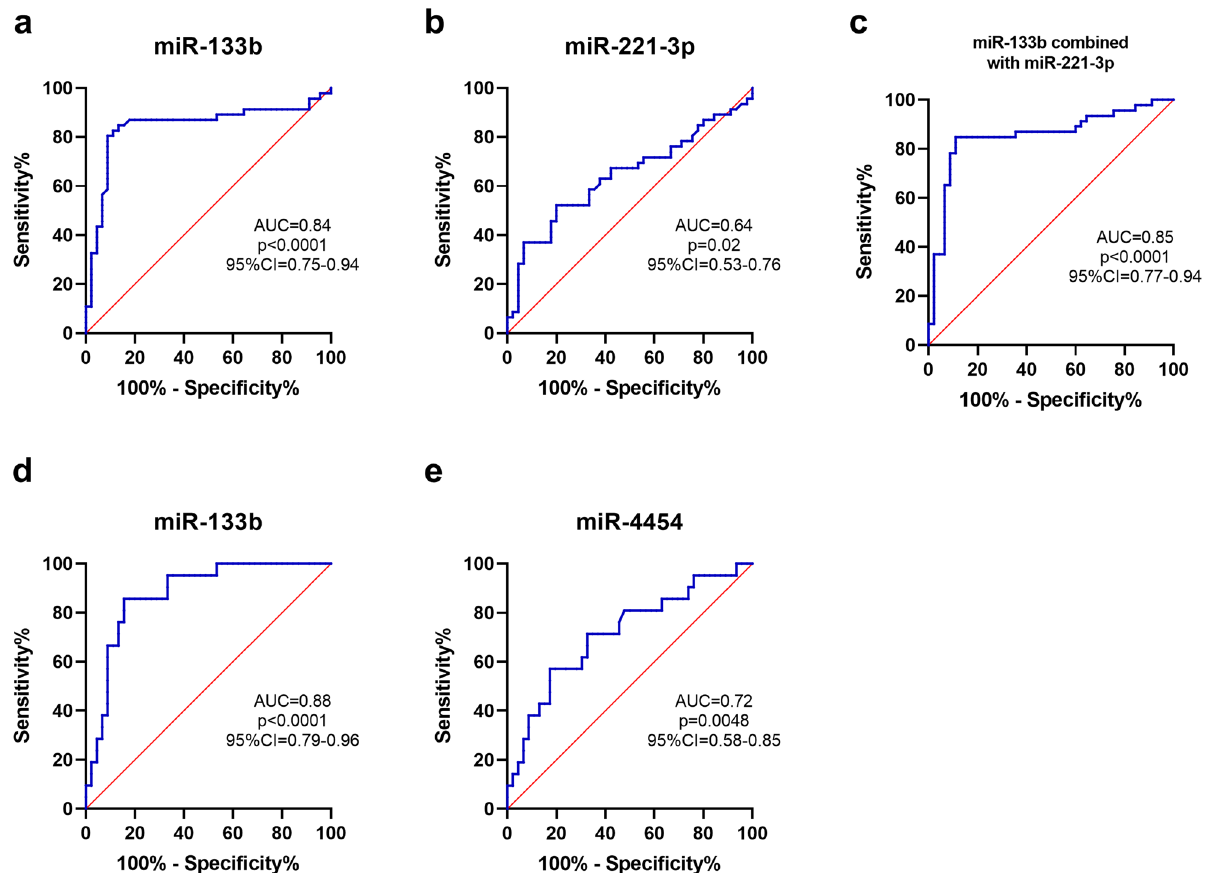
Figure 6. ROC analysis of plasma miRNAs as PD biomarkers. ( a – c ) ROC curves of miR-133b ( a ), miR-221-3p ( b ), and their combination ( c ) for discriminating patients with PD (n = 46) from healthy controls (n = 45) in cohort 3. ( d ) ROC curves of miR-133b for discriminating patients with MSA (n = 21) from healthy controls (n = 45) in cohort 3. (e) ROC curves of miR-4454 for discriminating patients with PD (n = 46) from patients with MSA (n = 21) in cohort 3. PD, Parkinson’s disease; MSA, multiple system